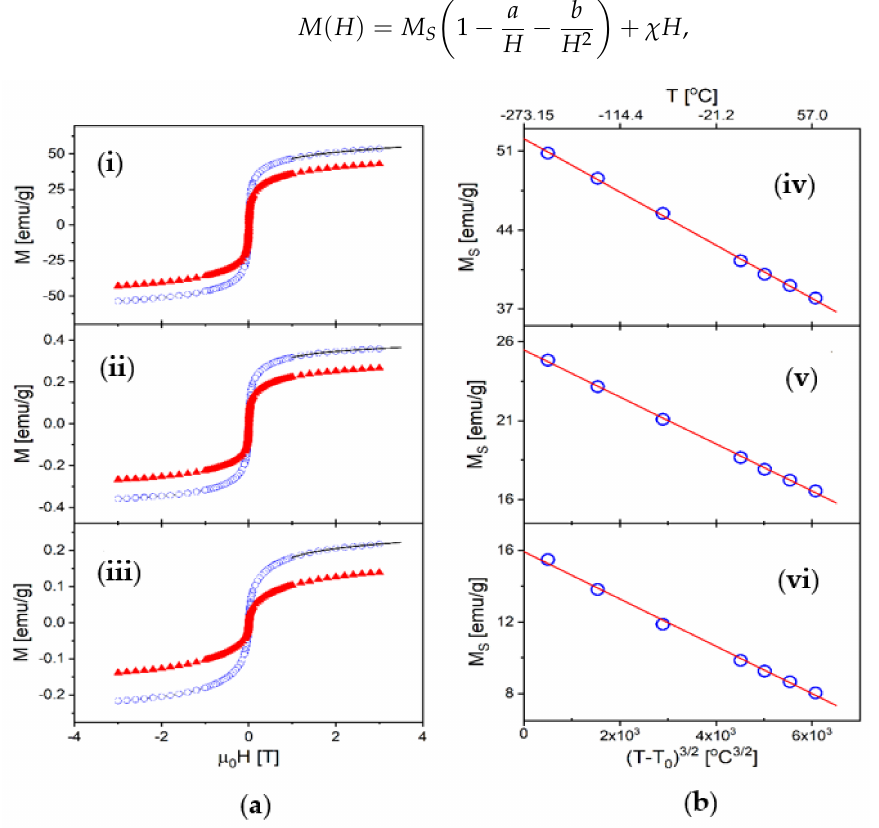
Figure 3. Magnetic properties: ( a ) Magnetization vs. applied magnetic field: ( i ) the free-standing nanoparticles, ( ii ) VCL-PEGDA-MNPs-MWCNTs, and ( iii ) VCL-PEGDA-MNPs-GO. The curves shown reflect measurements at two different temperatures, T = − 210 ◦ C (circles) and T = 20 ◦ C (triangles). The solid lines are examples of the fit of the data using the law of approach to saturation (LAS) of Equation (1). ( b ) Saturation magnetization as a function of temperature: ( iv ) the free-standing nanoparticles, ( v ) VCL-PEGDA-MNPs-MWCNTs and ( vi ) VCL-PEGDA-MNPs-GO. The solid lines match the data showing that MS follows Bloch’s law given Equation